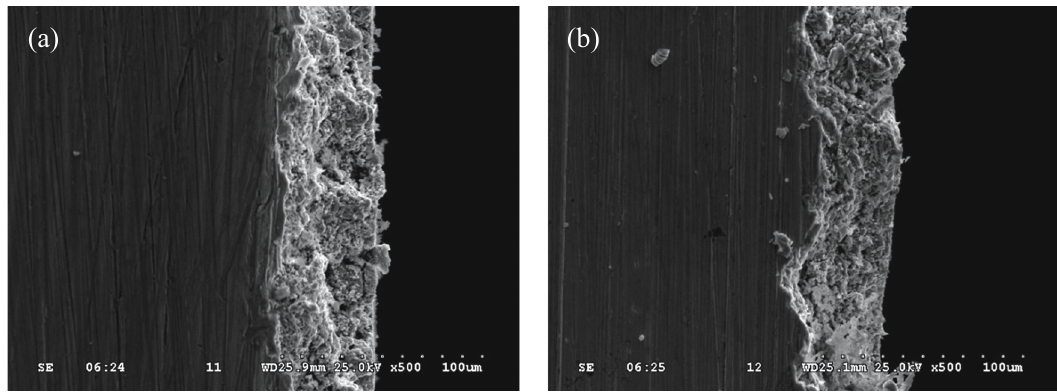
Figure 6: Pro fi le morphology of brass alloy with and without EPT ( a ) original sample and ( b ) 3 Hz.